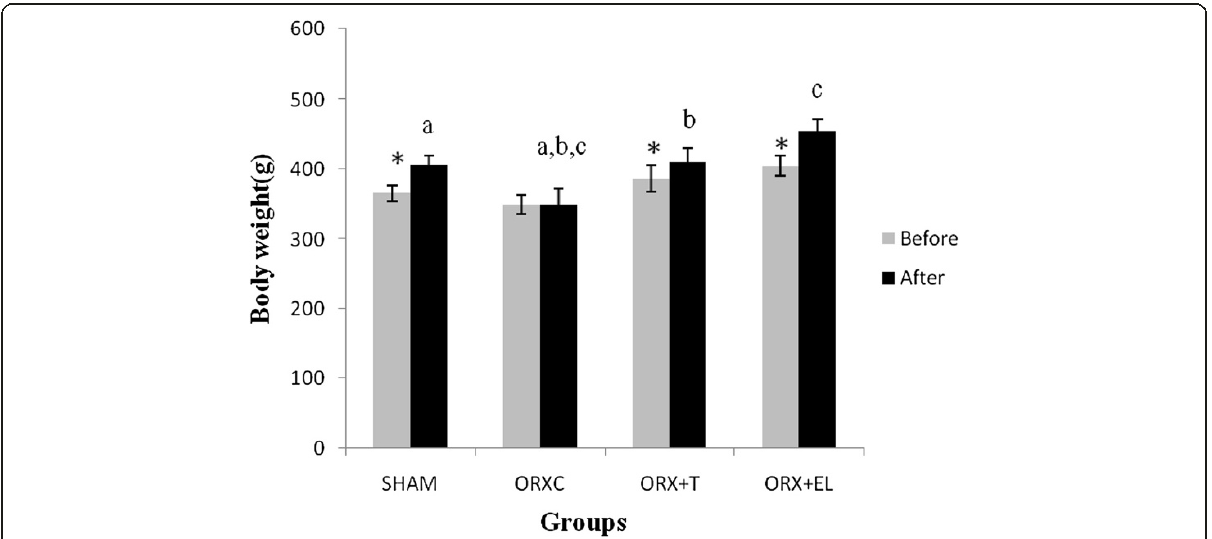
Figure 1 Mean rat weight before and after treatment. Data were presented as mean ± SEM with significant difference p < 0.05. *indicate significant difference before and after treatment. Same alphabet indicate significant difference between the groups after treatment. SHAM : Sham- operated group. ORX : Orchidectomized control group. ORX + T : Orchidectomized group treated by testosterone. ORX + EL : Orchidetctomized group treated with